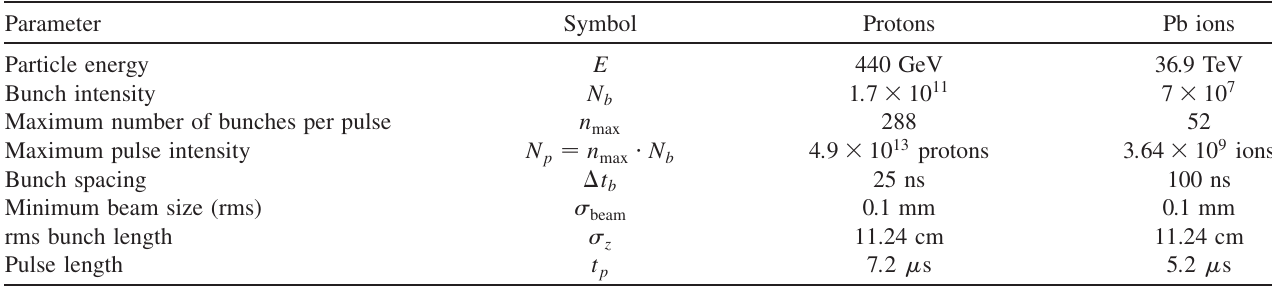
TABLE I. HiRadMat beam